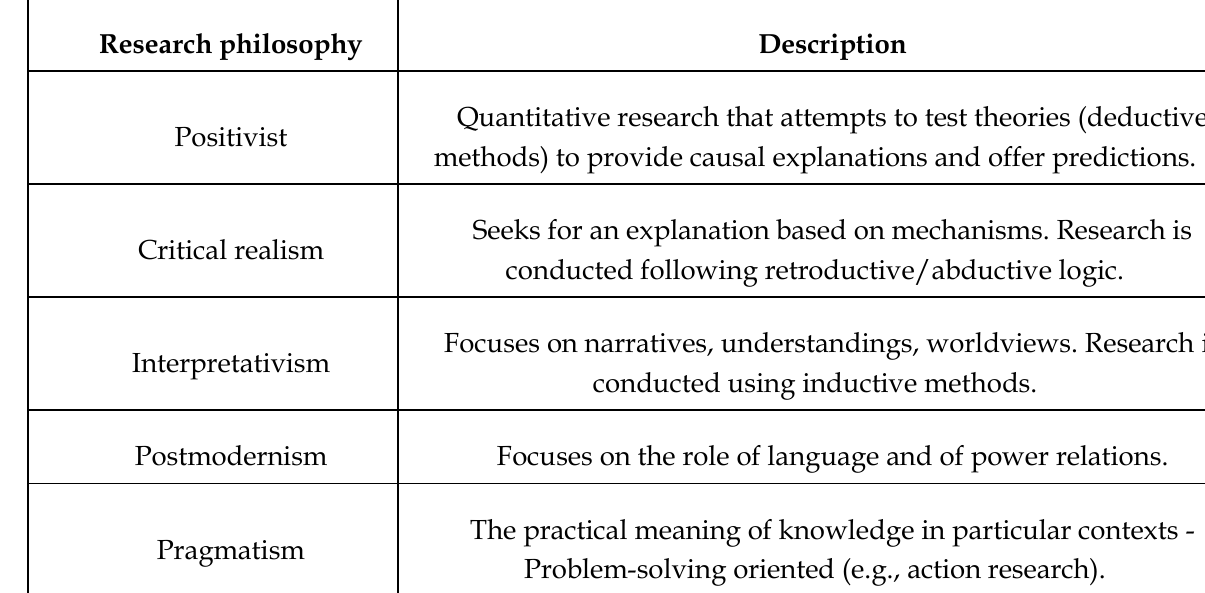
Table 2: Research philosophy Research